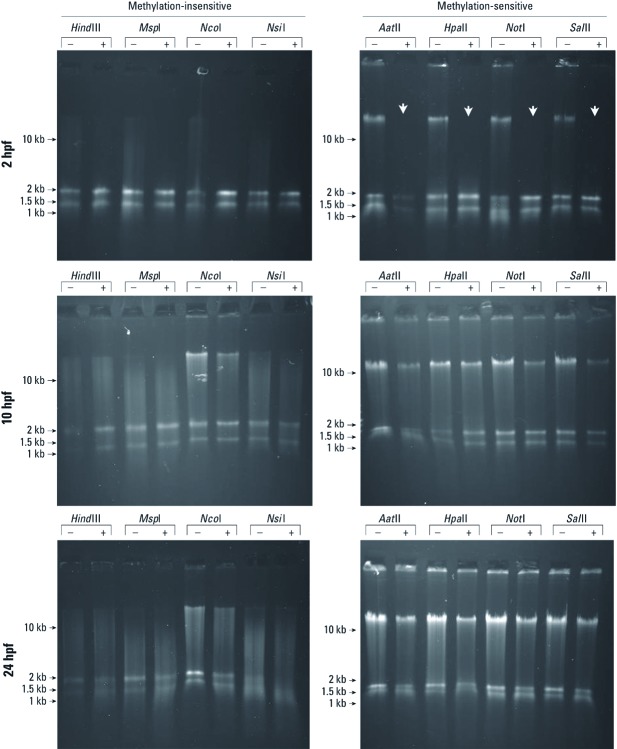
TDCPP and gDNA methylation during cleavage. gDNA extracted from TDCPP-treated embryos (+)—but not vehicle-treated embryos (–)—at the end of cleavage (2 hpf) was completely digested by methylation-sensitive restriction endonucleases (white arrows), suggesting that normal gDNA methylation at 2 hpf was absent in TDCPP-treated embryos. Gels are representative of three independent gDNA samples per time point and treatment.